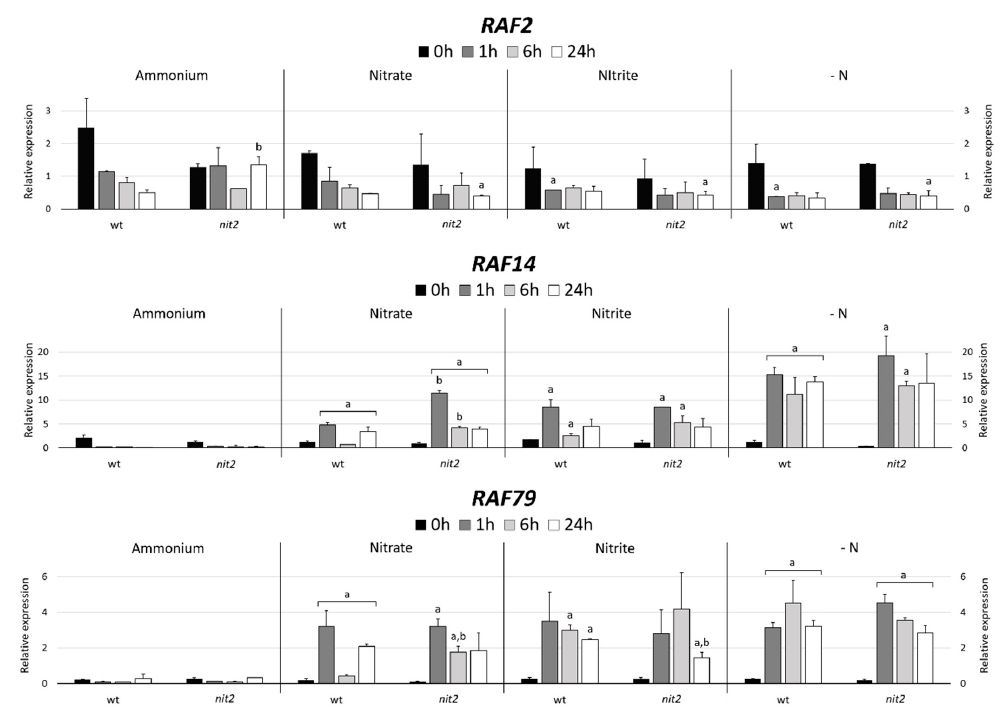
Figure 11. Quantification of RAF2 , RAF14 and RAF79 expression. The expression of MAPKKKs RAF 2, RAF14 and RAF79 were studied in the wt (704) and nit 2 (89.87), other conditions as in Figure 4.